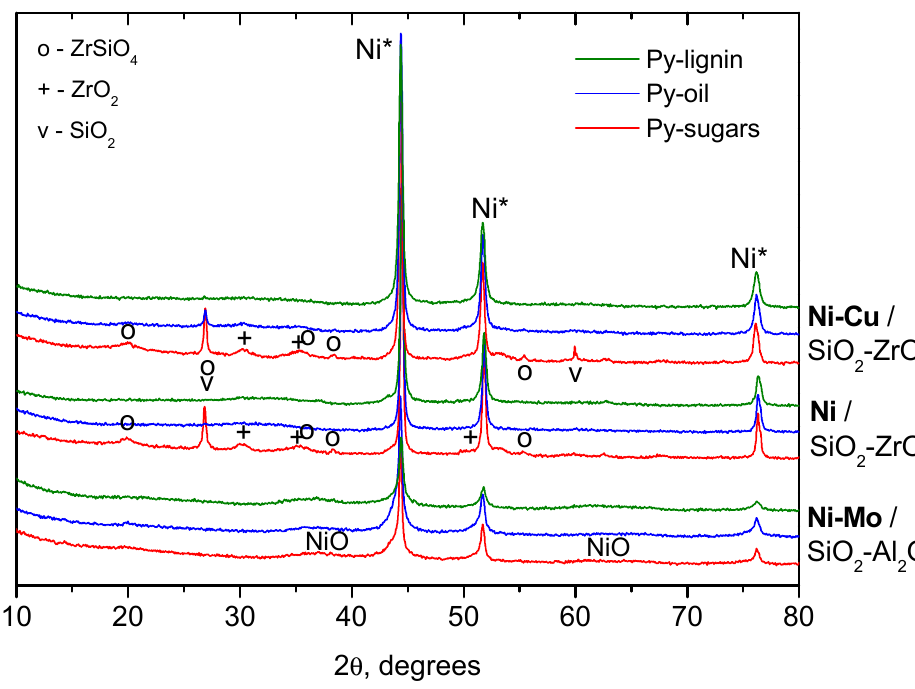
Figure 8. XRD patterns of spent catalysts after hydrotreatment with the three feeds: PL (green line), PO (blue line), PS (red line) at 350 °C, 4 h, 120 bar H 2 at RT.